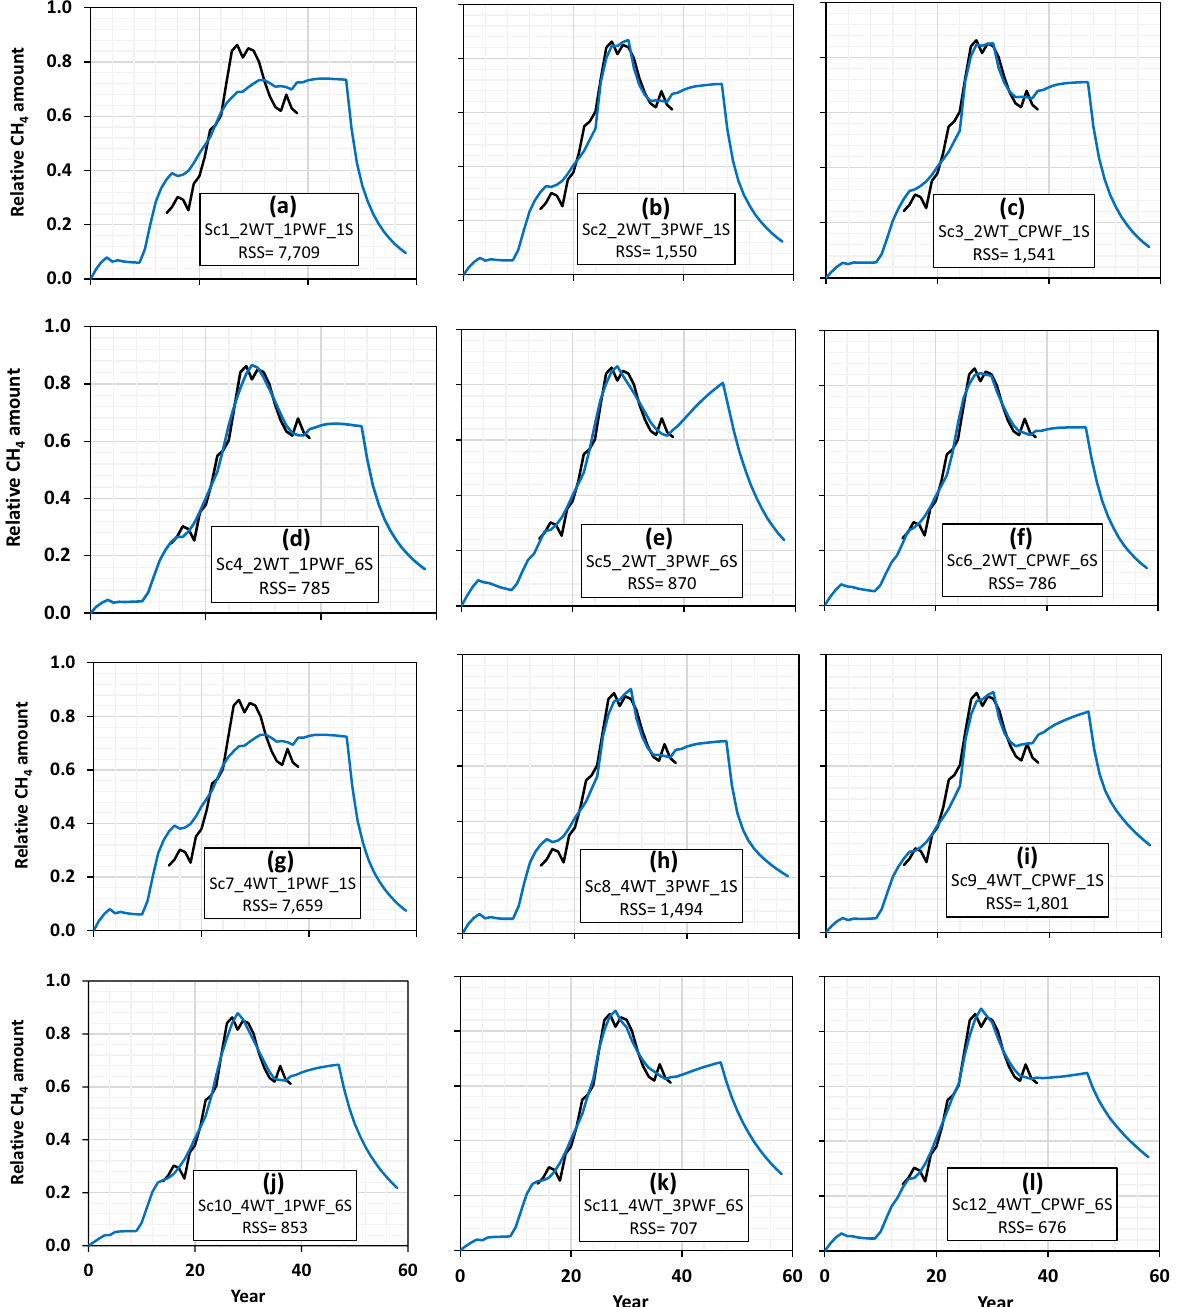
Fig. 3 Measured (black line) and modeled (blue line) total CH 4 generation of optimizing scenarios 1 to 12 (a to l) in relative values due to data fractions, six sectors, RSS: 870) and 6 (two waste types, constant three periodic waste fractions, six sectors, RSS: 786), although multiple variables have been added, RSS is greater than the RSS of scenario 4. Since different sec- tors are filled with waste at different times, considering